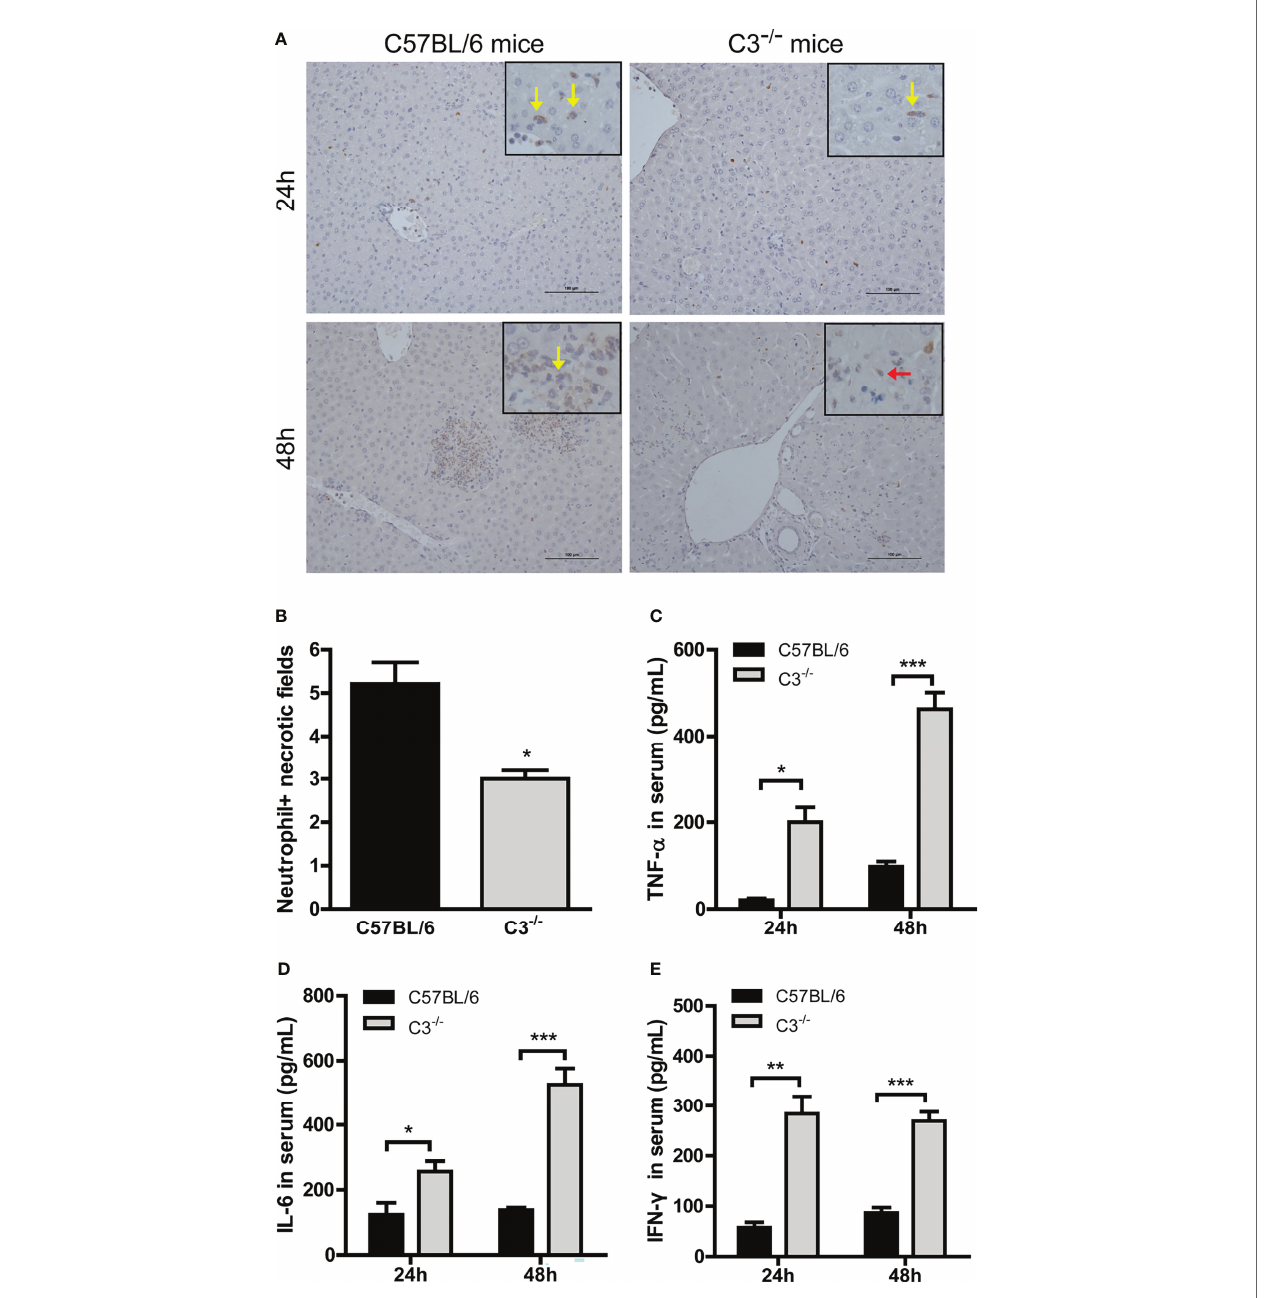
FIGURE 3 | Higher in fl ammatory responses in C3-de fi cient mice after MHV-3 infection. Serum and liver samples were obtained from WT and C3-de fi cient mice euthanized 24 and 48 hrs after MHV-3 challenge. (A) Immunohistochemical staining for neutrophil in fi ltration in liver samples (yellow arrow, in fi ltrated neutrophil; red arrow, necrotic hepatocytes). (B) Semiquantitative assessment of neutrophil in fi ltration in livers 24 hrs after virus infection. (C – E) Serum concentrations of proin fl ammatory cytokines 24 and 48 hrs after MHV-3 challenge. These results are representative of three independent experiments with similar results (n = 4 – 5 per group). * p <0.05, ** p <0.01, *** p <0.001 compared with WT control. Original magni fi cation, ×